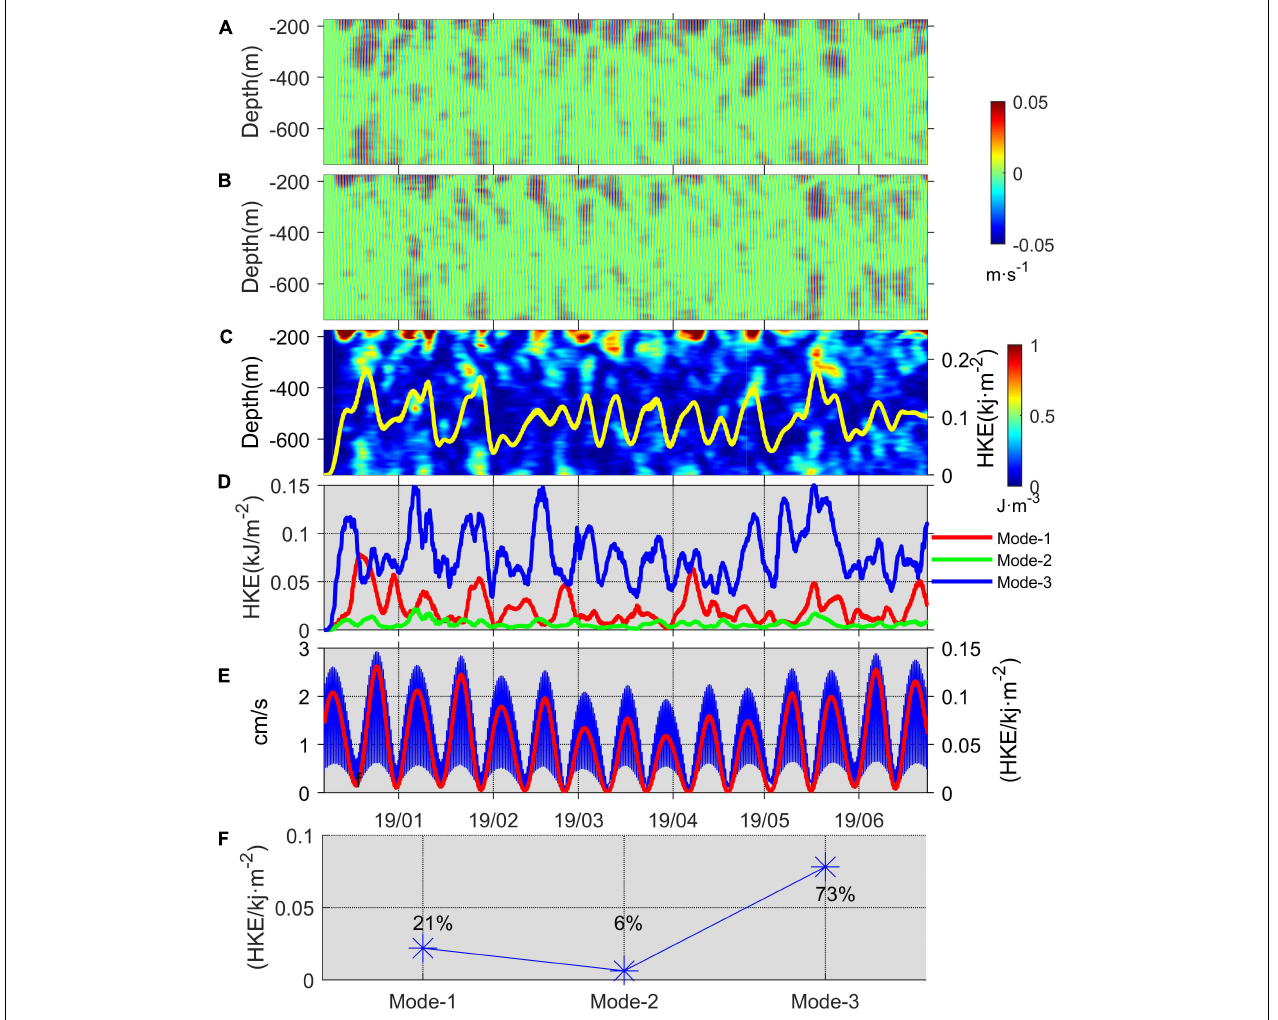
FIGURE 7 | Time series of the zonal velocity of diurnal ITs (A) and meridional velocity of diurnal ITs (B) . Distribution of diurnal ITs HKE (C) , yellow line for vertical integration. Time series of mode-1 (red), mode-2 (green), and mode-3 (blue) diurnal HKE (D) . Barotropic current amplitude (blue) and HKE (red) at diurnal band (E) . Horizontal labels mark the start of the month. Proportion of mode-1, mode-2, and mode-3 (F)